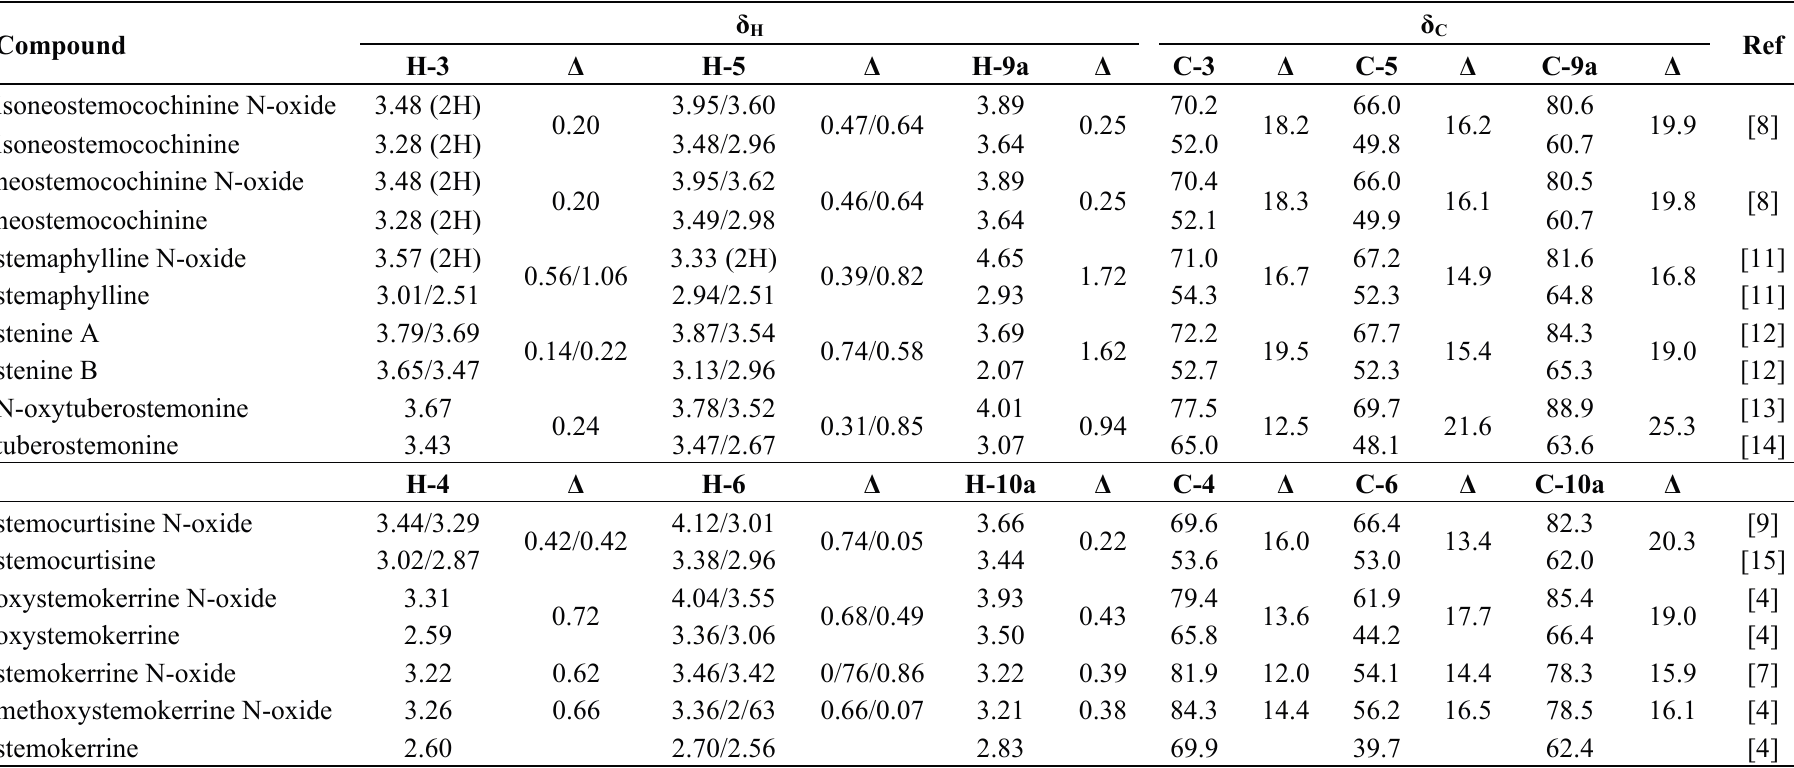
Table 2. Comparison of NMR data of N-oxide Stemona alkaloids and their